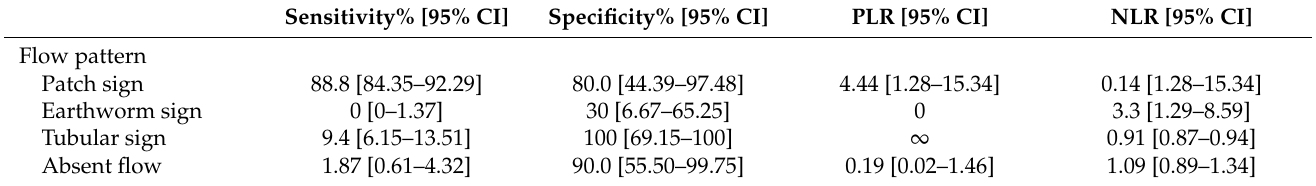
Table 3. Diagnostic performance of each flow pattern under Power Doppler ultrasound in predicting intraepidural injection during caudal epidural injection.